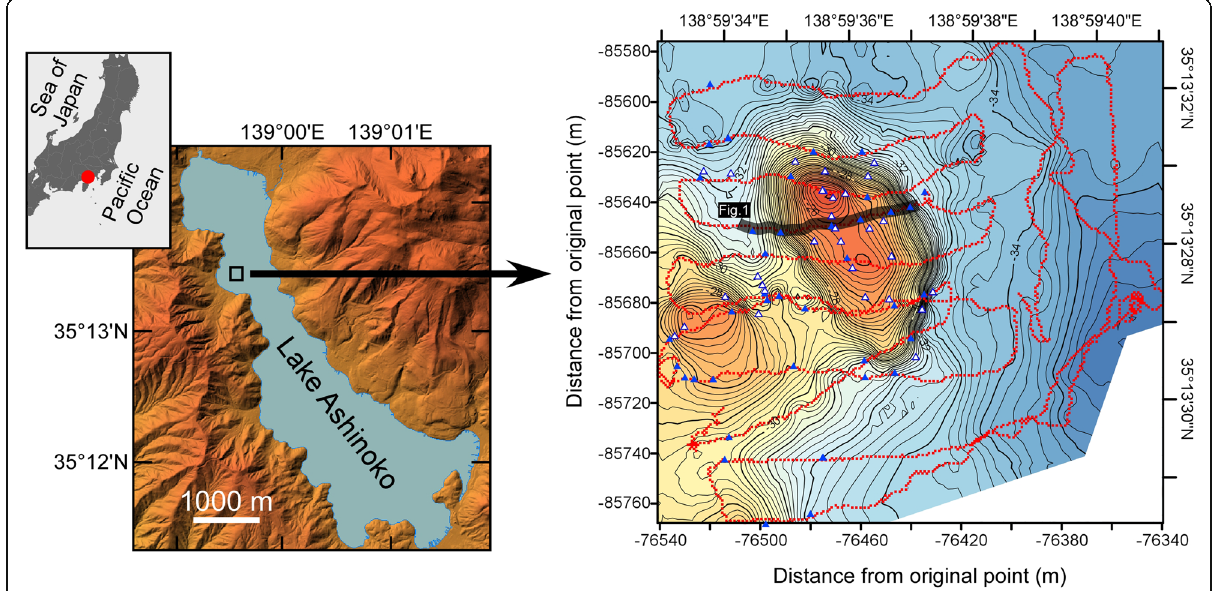
Fig. 5 The location of the study area and the bathymetric map (0.2 m interval in depth) obtained by our method. On the bathymetric map, the red dots are the depth measurement points, the blue solid triangles are the submerged trees detected by the high-resolution 455 kHz sonar imaging, and the blue open triangles are the trees detected by the side-scan 455 kHz sonar imaging (based on the ninth Japanese rectangular coordinate system; the top is the north and the original point is 36° 00 ′ 00 ″ N, 139° 50 ′ 00 ″